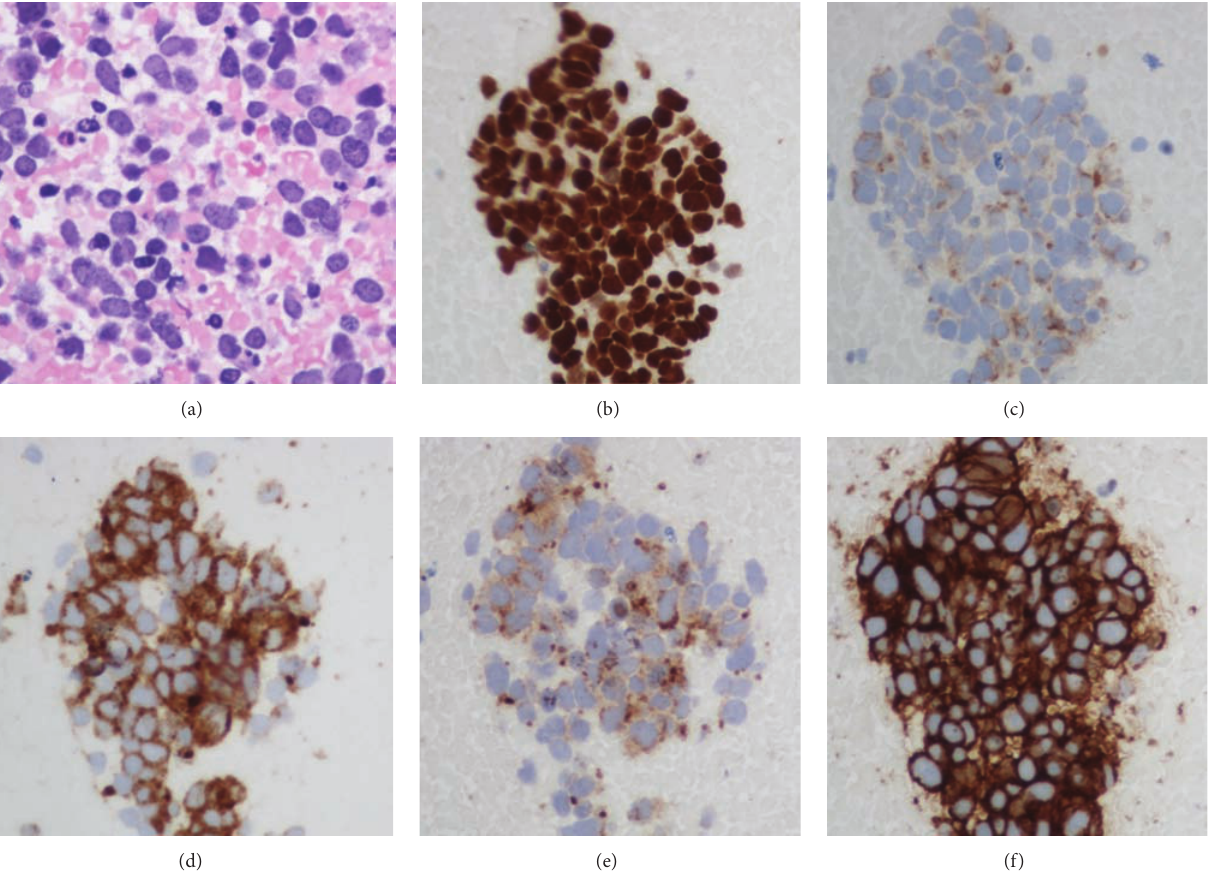
Figure 2: Representative cytology slides of paratracheal lymph node. Cytology of endobronchial ultrasound guided fine needle biopsy from the necrotic mediastinal lymph node in Figure 1. Hematoxylin and eosin stain of cell block section (a) demonstrated crowded, overlapping groups of malignant cells in a background of necrosis. Immunohistochemistry was positive for TTF-1 (b), AE-1/AE-3, perinuclear dot-like positivity (c), synaptophysin (d), chromogranin (e), and CD56 (f), confirming the diagnosis of small cell lung